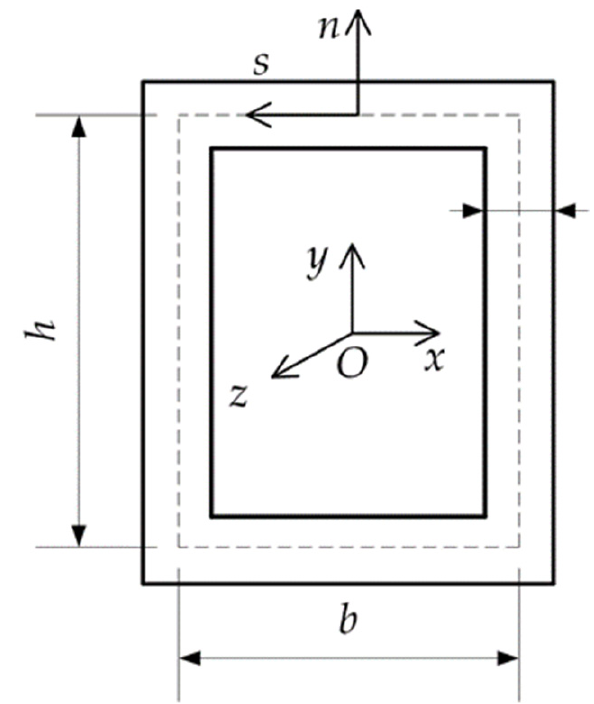
Figure 3. Box beam cross-section.